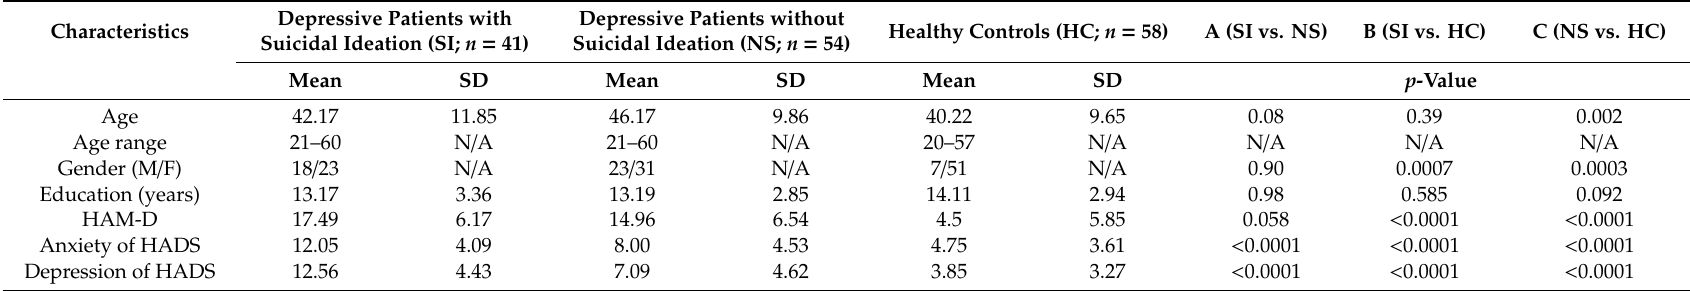
Table 1. Summary of characteristics of demographic data and neuropsychological tests.